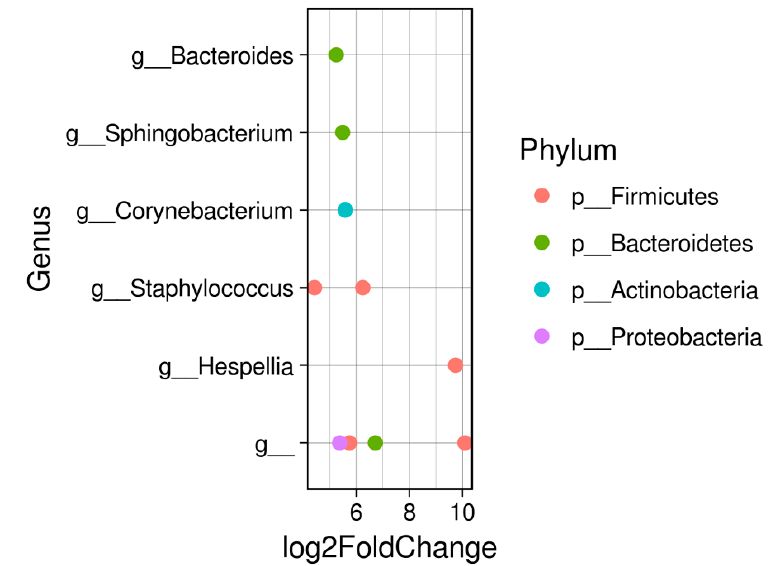
Figure 2. Analysis identifying statistically significant differences in intestinal microbiome components of Arapaima gigas . The positive values of the log2-fold change indicate that the operational taxonomic units (OTUs) are significantly higher in small fish than in large fish, considering p < 0.05.